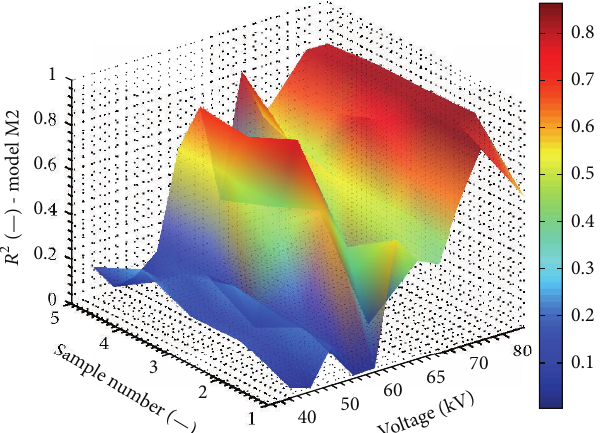
Figure 12: Comparison of 𝑅 2 obtained by regression of model M2 for all the recorded